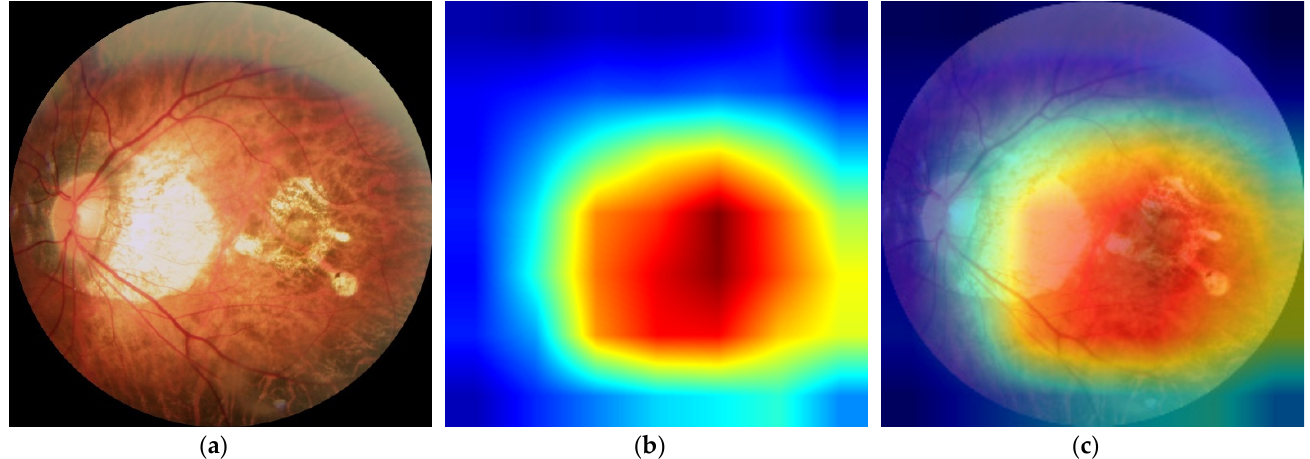
Figure 5. Visualization-based diagnosis by the DCNNs. ( a ) Original image. ( b ) Heatmap. ( c ) Grad-CAM++. Heatmaps and Grad-CAM++ showed that the DCNNs model focused on the macular area and the area of choroidal atrophy rather than the background.